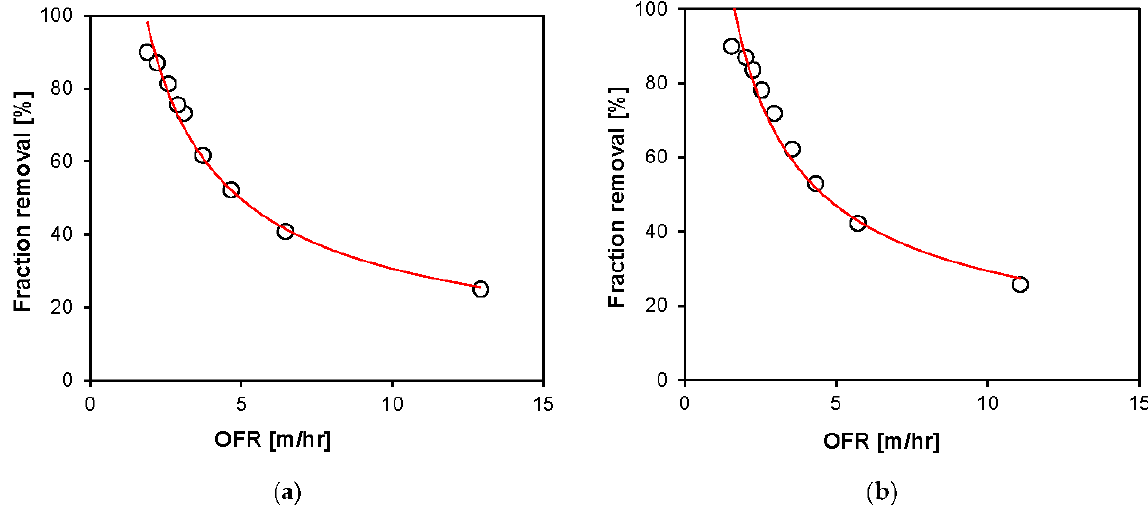
Figure 7. Fraction removal with OFR after EC process for ( a ) turbidity and ( b ) color.